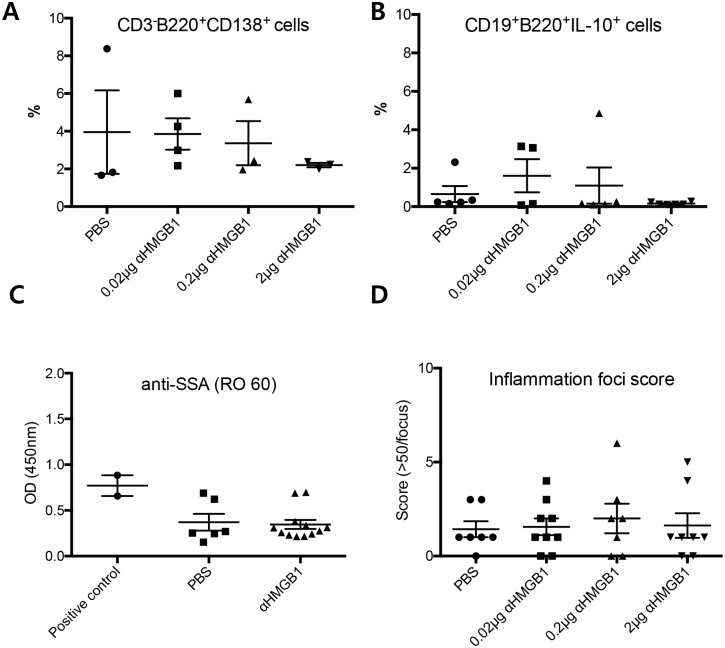
Changes in functional B cells in cervical lymph nodes, anti-SSA antibodies in serum, and inflammation foci scores in extra orbital lacrimal glands in NOD.B10.H2b mice after anti-HMGB1 treatment.(A) No significant change in percentage of plasma cells (CD3-B220+CD138+ cells). (B) No change in IL-10-secreting B regulatory cells (CD3-CD19+B220+IL-10hi). (C) No change in the level of anti-SSA (RO 60) antibodies after treatment. (D) No significant changes in inflammatory foci scores (> 50 lymphocytes/focus) among all groups. Data are presented as mean ± standard error.